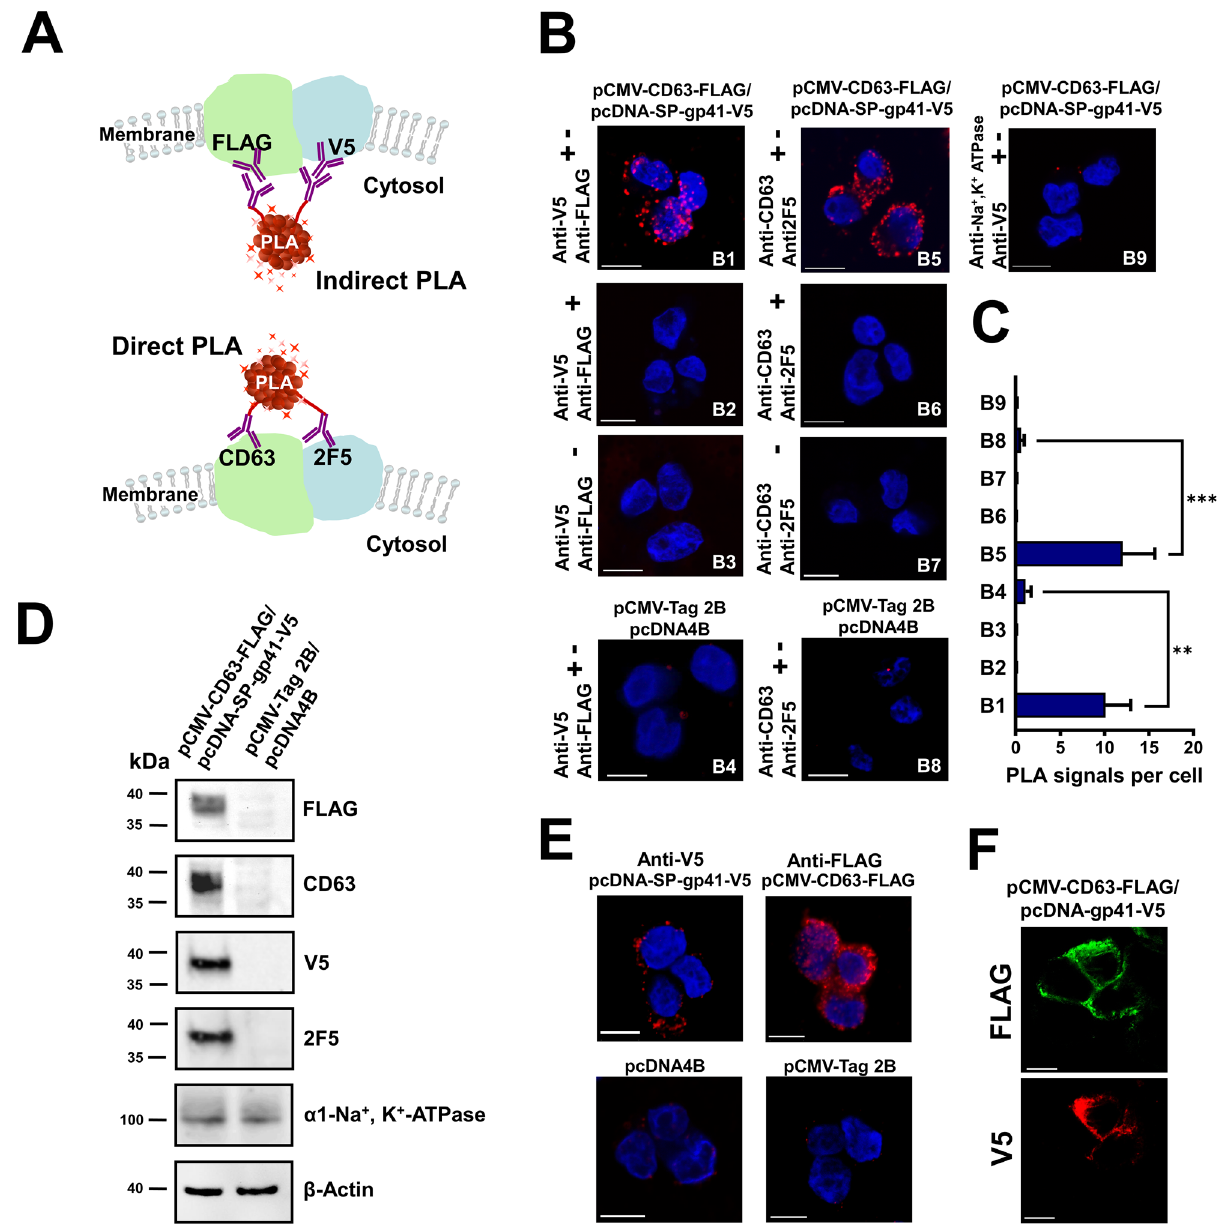
Figure 4. Detection of the interaction between CD63 and gp41 by PLA. ( A ) A schematic illustration of direct and indirect PLA experiments. Indirect PLA was performed by detecting FLAG and V5 epitopes by primary antibodies and direct PLA by conjugation of primary antibodies recognizing CD63 and gp41 (2F5) specific epitopes. ( B ) Confocal images of HEK293T cells co-transfected with indicated vectors. Indirect PLA was performed on B1–B4, B9 and direct PLA on B5–B8. ( C ) Quantification of PLA signals per cell obtained for the expressed protein pair SP-gp41-V5/CD63-FLAG from independent transfections: B1 (n = 100), B2 (n = 97), B3 (n = 100), B4 (n = 100), B5 (n = 110), B6 (n = 96), B7 (n = 95), B8 (n = 105), and B9 (n = 160). ( D ) Western blot analysis of transfected HEK293T cells used for PLA experiments expressing CD63-FLAG and SP-gp41-V5; whole-cell lysates were probed with the indicated primary antibodies. ( E ) Confocal images of protein expression control by FLAG and V5 by single recognition PLA. ( F ) Confocal images of indirect immunofluorescent staining for expressed CD63-FLAG and SP-gp41-V5 using transfected HEK293T cells from PLA proteins. Especially the expression of gp120 that undergo a trimeric association with gp41 (pre-fusion confirma- tion) will enable to reach close physiological conditions. This HIV-1 clone is based on the NL4-3 isolate but con- tains the R5-tropic envelope of the JR-FL isolate in addition to a GFP gene inserted between the matrix and the capsid sequence flanked by the viral protease cleavage sites SQNYPIVQ 41 . The HIV JR-FL envelope was selected in order to avoid infection by free floating virus particles of Jurkat cells. It was shown that cell-to-cell transfer is independently from CCR5 co-receptor expression 2 . At 24 h post-transfection with HIV JR-FL Gag-iGFP, the Jurkat